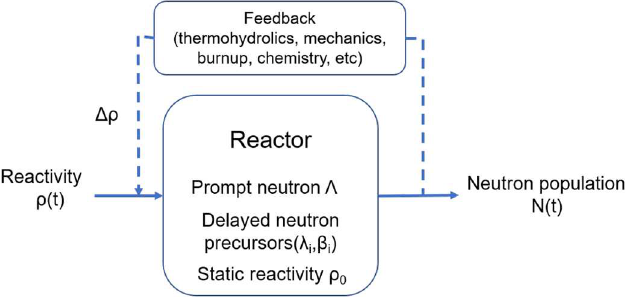
Fig. 1. LTI representation of a nuclear reactor in the framework of